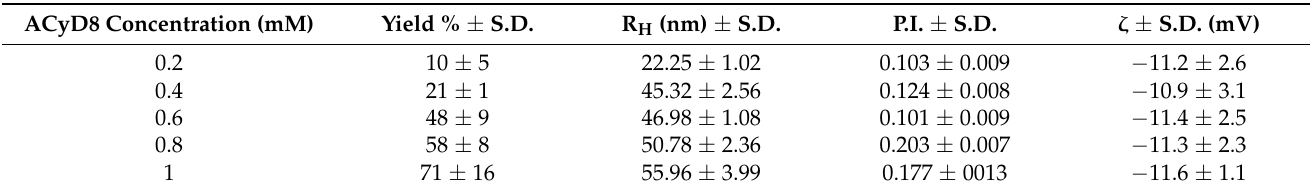
Table 1. Yield %, sizes, polydispersity index (P.I.) and zeta potential ( ζ ) of blank ACyD8 NPs. ACyD8 Concentration (mM) Yield % ± S.D.